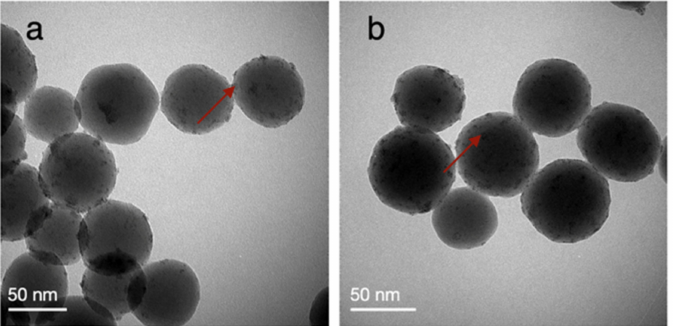
Figure 5. BFTEM images of Ru/SiO 2 -CR with a Ru loading of 3.34% w / w ( a ) before and ( b ) after sunlight-powered Sabatier’s reaction. Reaction conditions: reaction mixture of H 2 /CO 2 /N 2 (4.5:1:1) at 3.5 ± 0.2 bar pressure, 200 mg of Ru/Al 2 O 3 or Ru/SiO 2 catalyst, light intensity of 6.66 suns, catalyst bed temperature of approximately 220 ◦ C. The red arrows illustratively point out a supported Ru